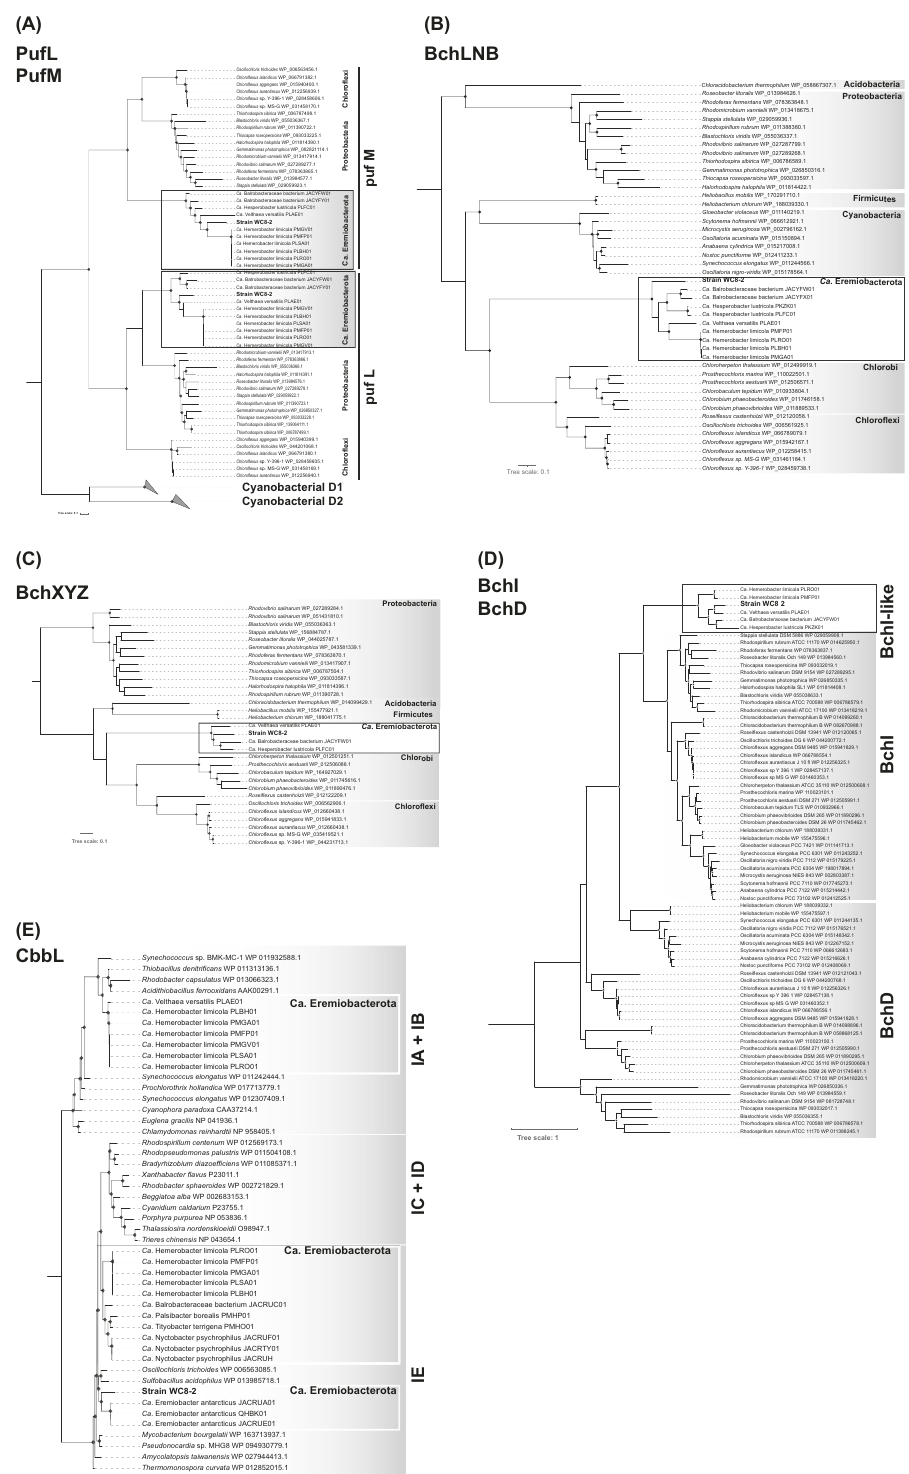
Gene transcripts related to phototrophy with non-labeled CO 2 was − 22.9 ± 0.7 ‰ and − 21.7 ± 0.2 ‰ in light Transcription of the RC genes (pufL and bchM), the type IE RuBisCO (photoheterotrophic condition) and dark (chemoheterotrophic large subunit gene (cbbL), and an internal reference gene (rpoB) condition), respectively. That of WC-8 cells with isotope-labeled ‰ and 1602.2 ± 572.8 ‰ in the light and 13 CO was assessed by qRT-PCR using exponentially growing cells. The 2 was 2279.4 ± 719.9 standard RT-PCR products were identi fi ed as the sequences of pufL dark respectively (Table 2).